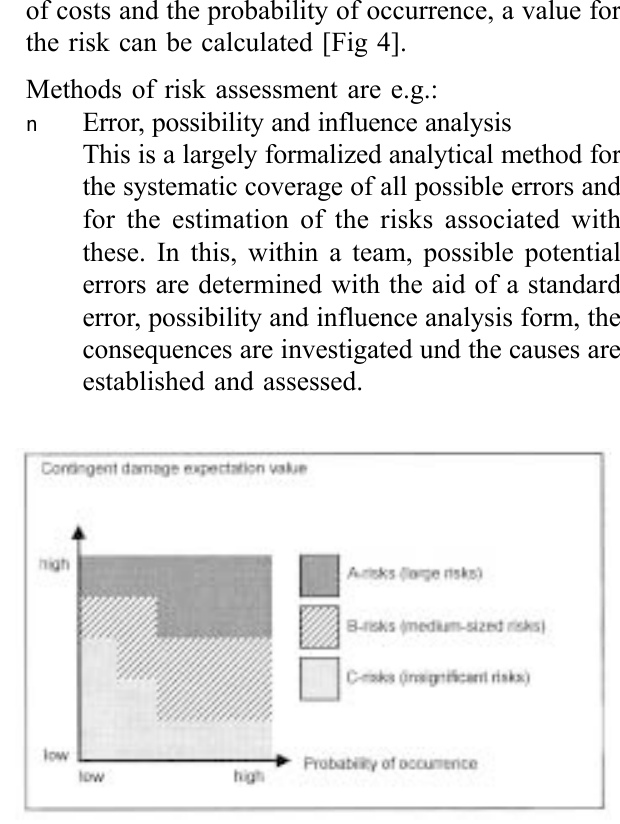
Fig 3. Methods of risk identification (according to G(cid:246)cke, p. 143) Fig 4 . Risk